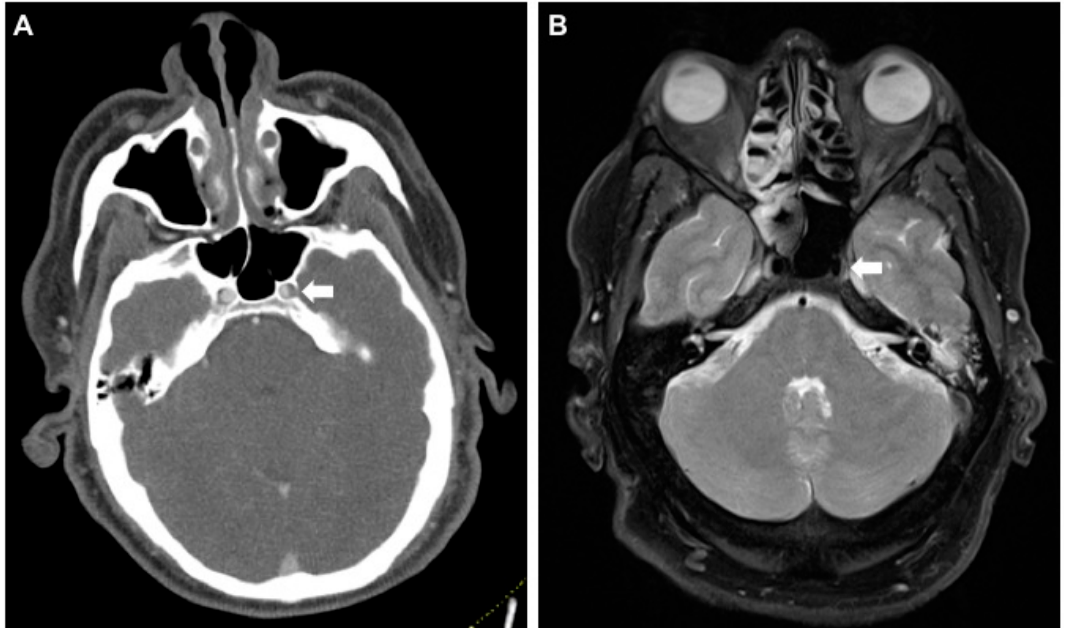
Figure 2. False-positive CT-A raising suspicion for an intramural hematoma of the left internal carotid artery (ICA) in its petrosal segment. ( A ) Axial CT-A of the skull base shows caliber asymmetry of the left ICA in the foramen carotideum (white arrow). ( B ) MR (proton-density fat saturated) rules out a wall hematoma. Asymmetry is presumably caused by the carotid plexus of nerves and sympathetics from the superior cervical ganglion (white arrow). MR, magnetic resonance.